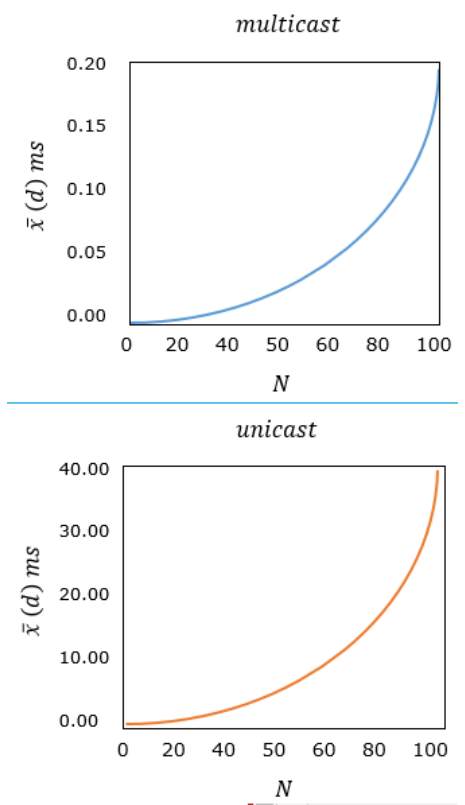
Fig. 7: Unicast and Multicast average delay scores randomly generated by R Statistical Software.